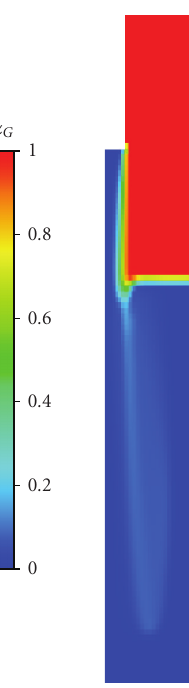
Figure 18: Gas void fraction for a very small bubble drag coe ffi cient.